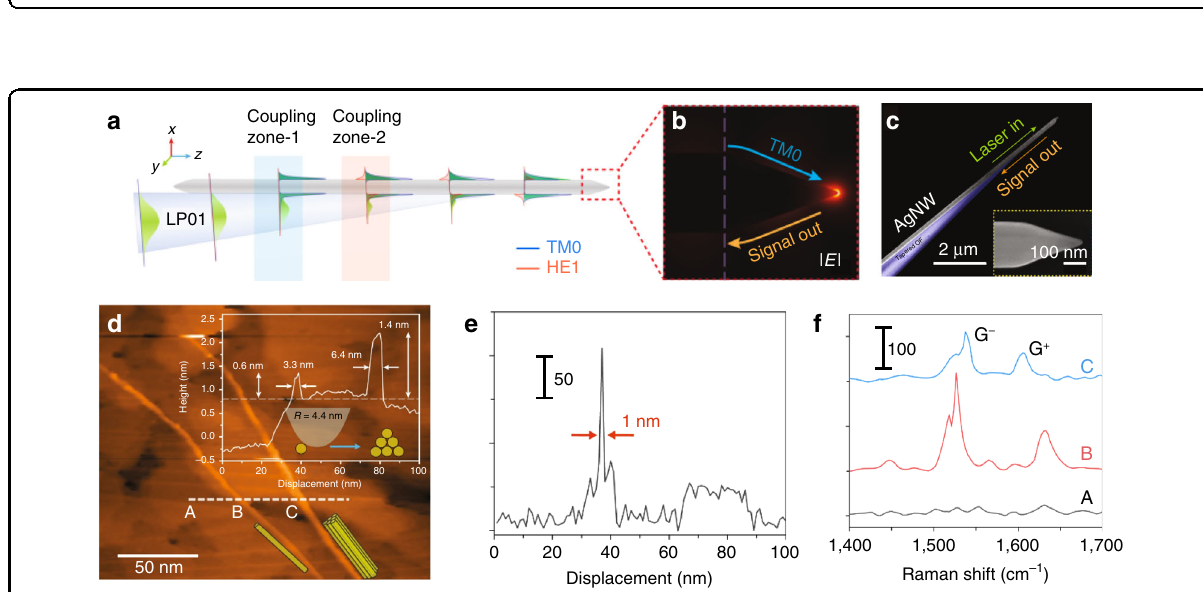
Fig. 13 Fiber-coupled TERS tip. a The phase-matching zones for TM 0 and HE 1 modes are separated for the selective excitation of the former. b Simulation of the nanofocusing at the AgNW tip (tip angle 37°), with TM 0 input from the left. The light wavelength is 532 nm for all calculations. c False-color SEM images of a fabricated AgNW-OF probe. The OF tip region (blue) is uncovered for the selective and effective excitation of the TM 0 SPP on a sharp-tip silver nanowire (200 nm in diameter, ~5 nm in tip radius). Inset of c : enlarged view of the AgNW tip. d STM topographic image of SWCNTs on an Au fi lm. Top inset: cross-sectional pro fi le along the dashed line. Bottom inset: the possible con fi gurations of the bundle. e Intensity of the Raman peak at 1526 cm − 1 along the white dashed line in ( d ). A, B, C in d and e indicate the position of the Raman spectra in ( f ). Reprinted with permission from ref. 107 from Springer Nature: Nature Photonics, Copyright